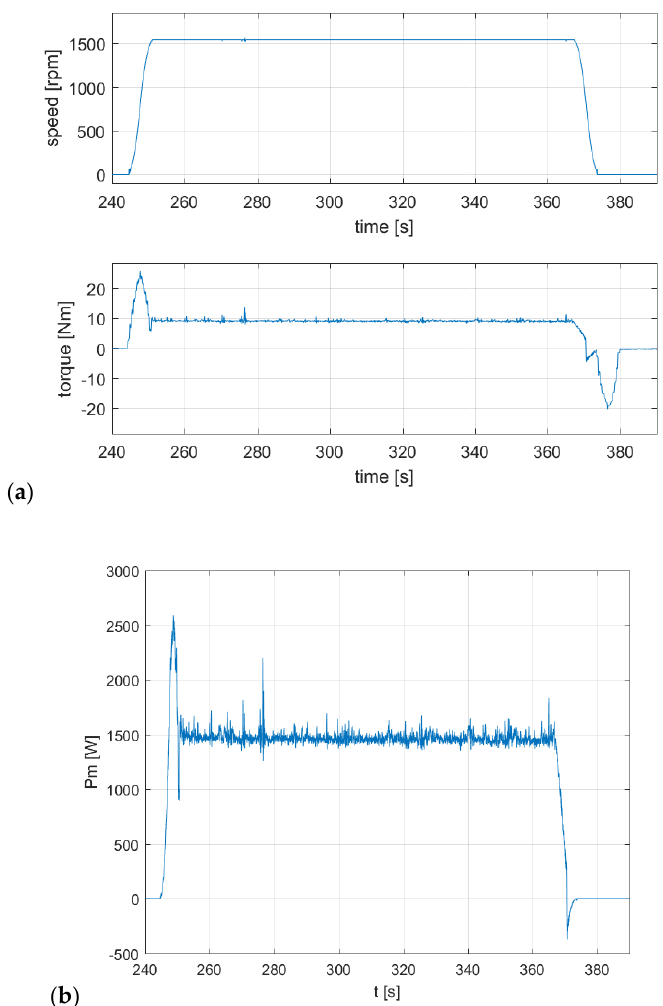
Figure 20. Recorded waveforms of torque, speed ( a ) and mechanical power ( b ) on the motor shaft during a given cycle of work C. during a given cycle of work